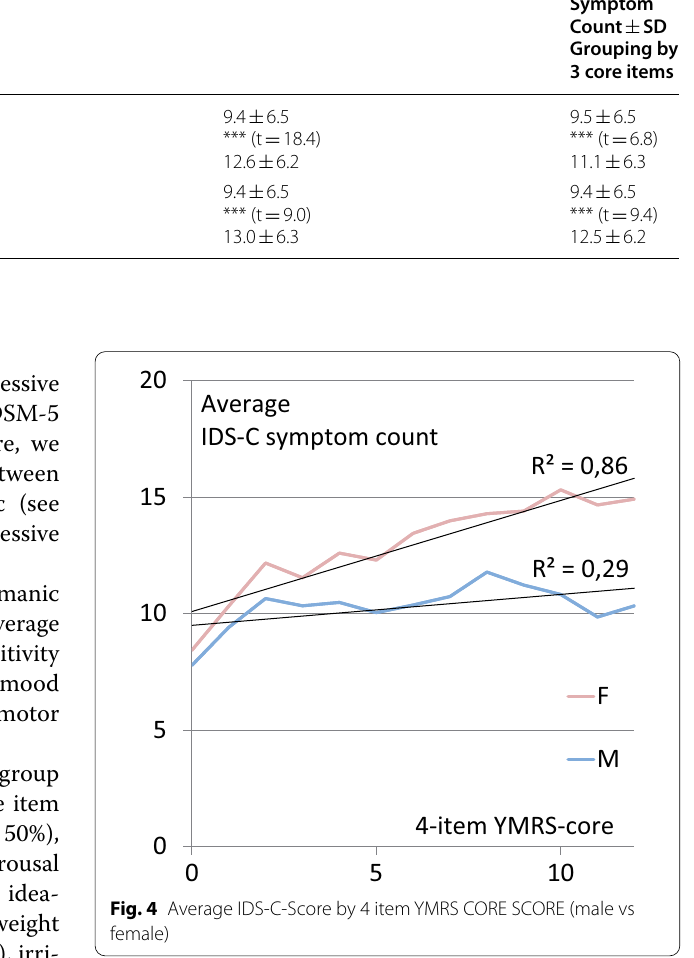
Table 4 Mean IDS-C SYMPTOMCOUNT for the YMRS-groups (total and core items) in the full sample